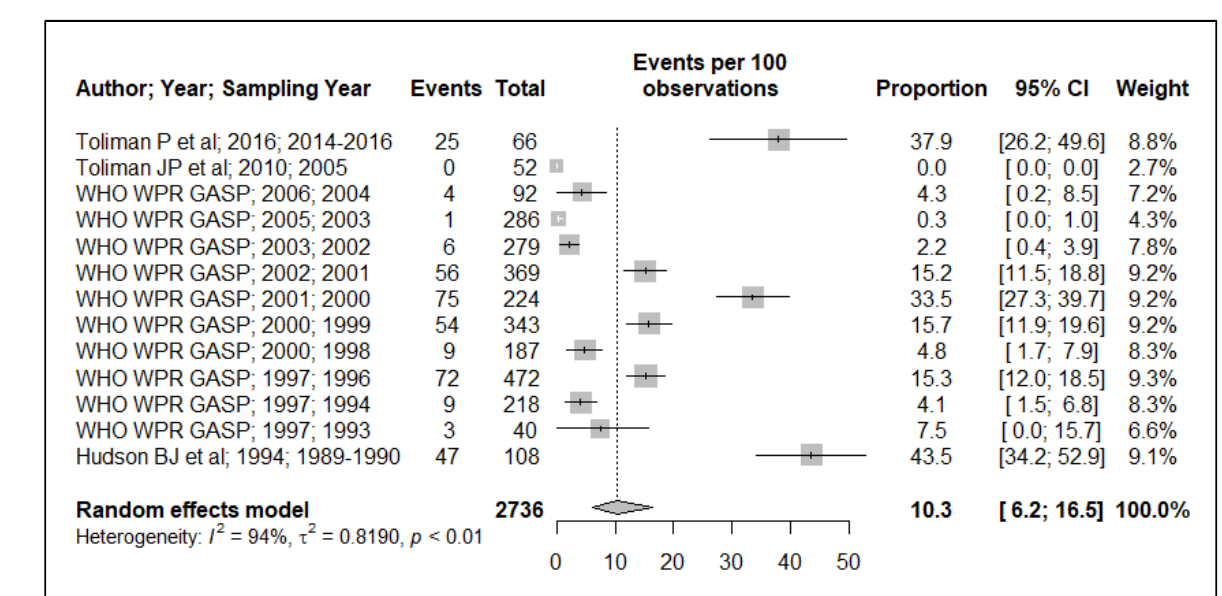
Figure 3. Chromosomally-mediated resistance to penicillin prevalence estimate.